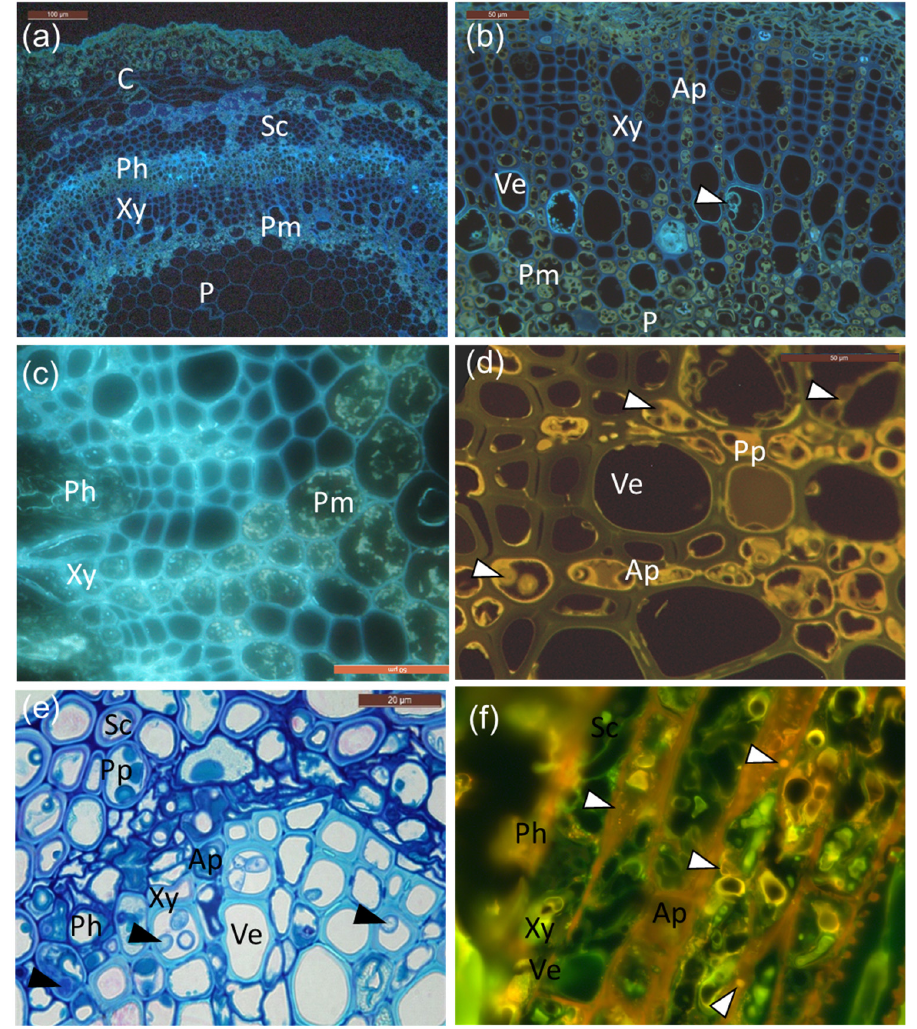
Figure 4 . Cellular localization of suberin and phenolics in infected petioles. ( a ) UV auto-fluorescence of infected petioles showing suberin as bright light blue droplets and aligning cell walls in the phloem and vessel elements. ( b ) Larger magnification of the cells (mainly vessel elements) and areas of the perimedullary region, note the tylosis-like structures (arrowhead) and suberin-coating in vessels. Perimedullary parenchyma cells and axial parenchyma aligning vessels are filled with phenolic aggregates and droplets, surrounding the ground tissue of the pith. ( c ) Grainy deposits. ( d ) Characteristic yellow auto-fluorescence of polyphenolic compounds, which were especially pronounced in the axial parenchyma but also in some vessel elements. Hyphae indicated by white arrowheads. ( e ) Phenolic compounds accumulating in sclerenchyma, axial parenchyma, and vessel elements, together with fungal hyphae (black arrowheads). ( f ) Staining with Nile red shows neutral lipids as yellow–gold droplets when illuminated with UV-light (330–380 nm) in the rachis section from infected clone 27x. C: cortex; Ph: phloem; Xy: xylem; P: pith; Sc: sclerenchyma; Pm: perimedullary parenchyma; Ve: vessel elements; Ap: axial parenchyma; Pp: polyphenolics. Scale bars: a, 100 µm; b, c, d, f, 50 µm; e, 20 µm.